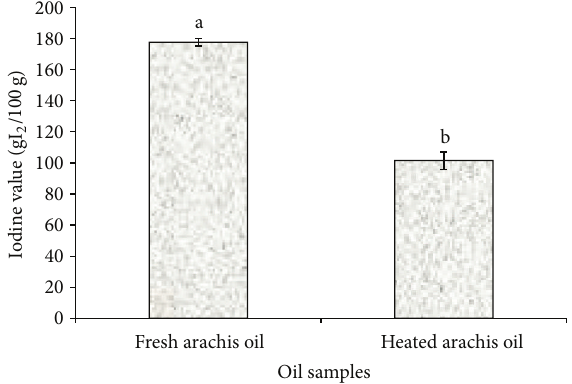
Figure 3: Effect of thermal oxidation on acid value of arachis oil. Acid values are expressed as mean ± standard deviation ( 𝑛 = 3 ). Bars with different alphabets are significantly different ( 𝑃 < 0.05 ).